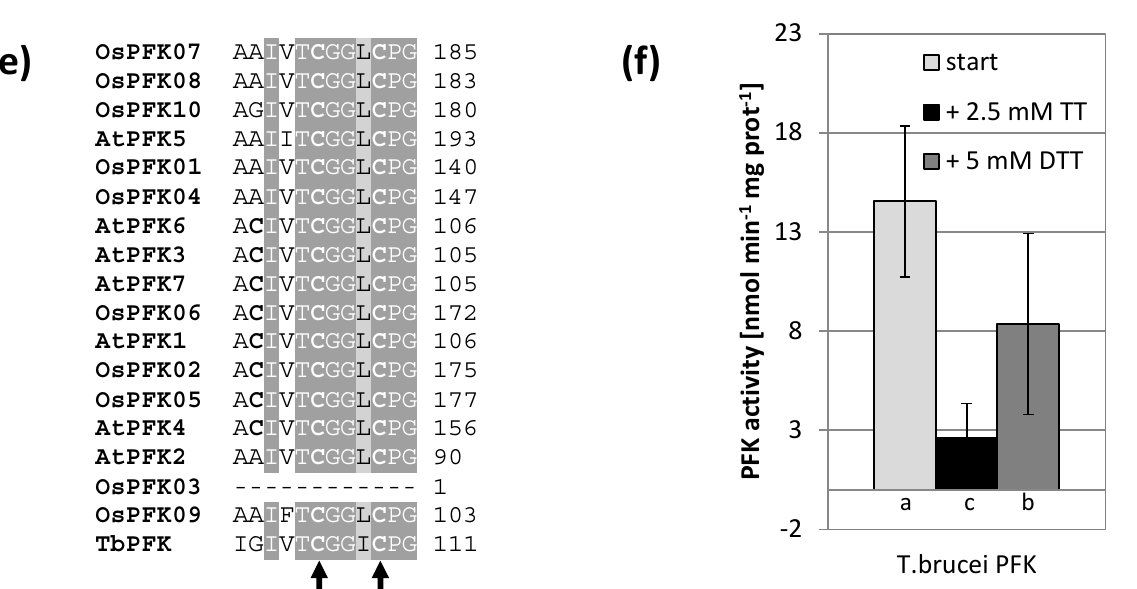
Figure 4. Impact of the CGG(L/I)C motif on PFK activity and oxidation sensitivity. Cys to serine single and double mutations were introduced in the CGG(L/I)C motif of A. thaliana AtPFK3 and AtPFK5 proteins. The variants were transiently overexpressed in tobacco leaves ( a – d ). Wildtype PFK from T. brucei ( f ) as well as PFKs from the tobacco leaf samples ( a – d ) were extracted with buffer containing 5 mM β -mercaptoethanol ( β -ME). After initial activity determination, samples were oxidized with 2.5 mM sodium tetrathionate (TT) for 20 min, and afterwards re-reduced with 5 mM dithiothreitol (DTT). Upper case letters indicate significant differences for each isoform to buffer and GFP control, lower case letters indicate significant differences among treatments for each isoform at p < 0.05 (ANOVA, Post hoc Tukey test, n = 3–6). The results are means ± SD. ( e ) Detail of the protein alignment of the CGG(L/I)C motif in PFKs from A. thaliana , O. sativa and T. brucei . The two mutated Cys are marked with an arrow.